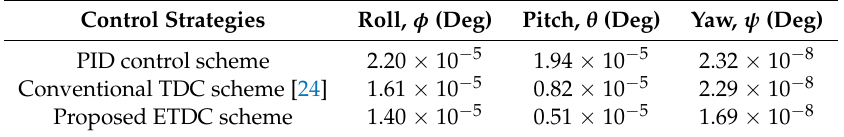
Table 1. RMS values of trajectory-tracking errors (Figure 5a) measured from 5 s to 10 s.